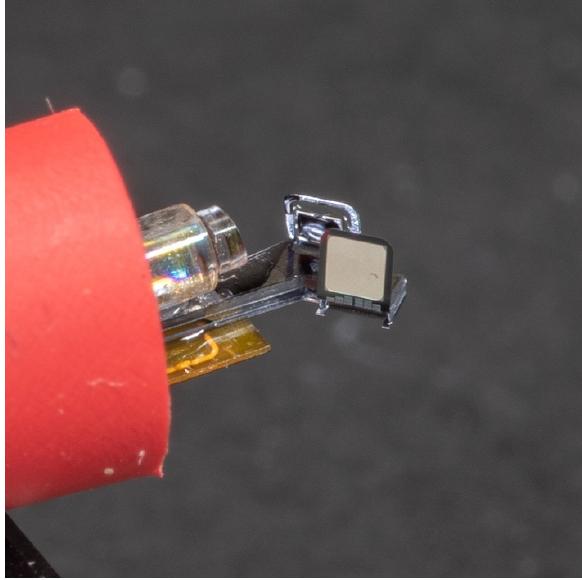
Figure 10. Photo of an assembled probe.